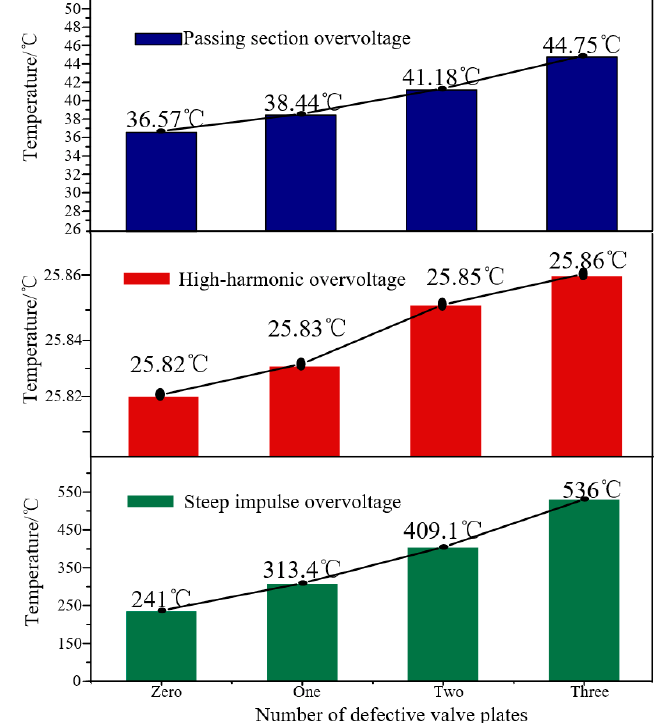
Figure 19. The influence of the defective valve plate number on the temperature rise.